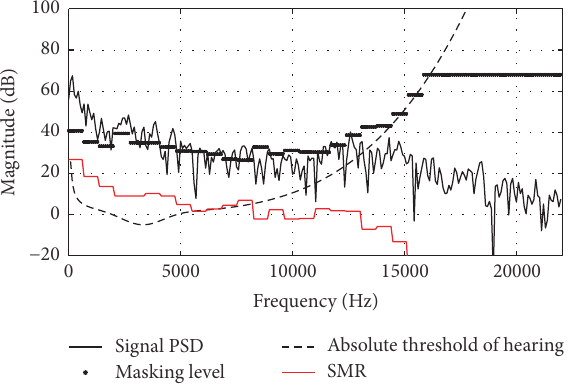
Figure 4: Signal PSD, global masking level, and